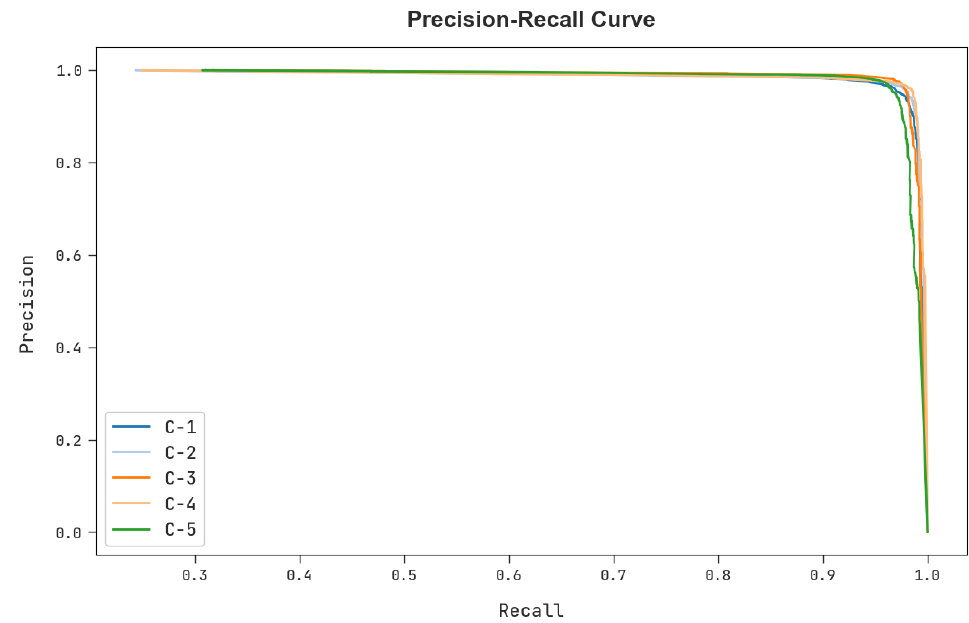
Figure 7. Precision recall analysis of AOEDBC-DL system.